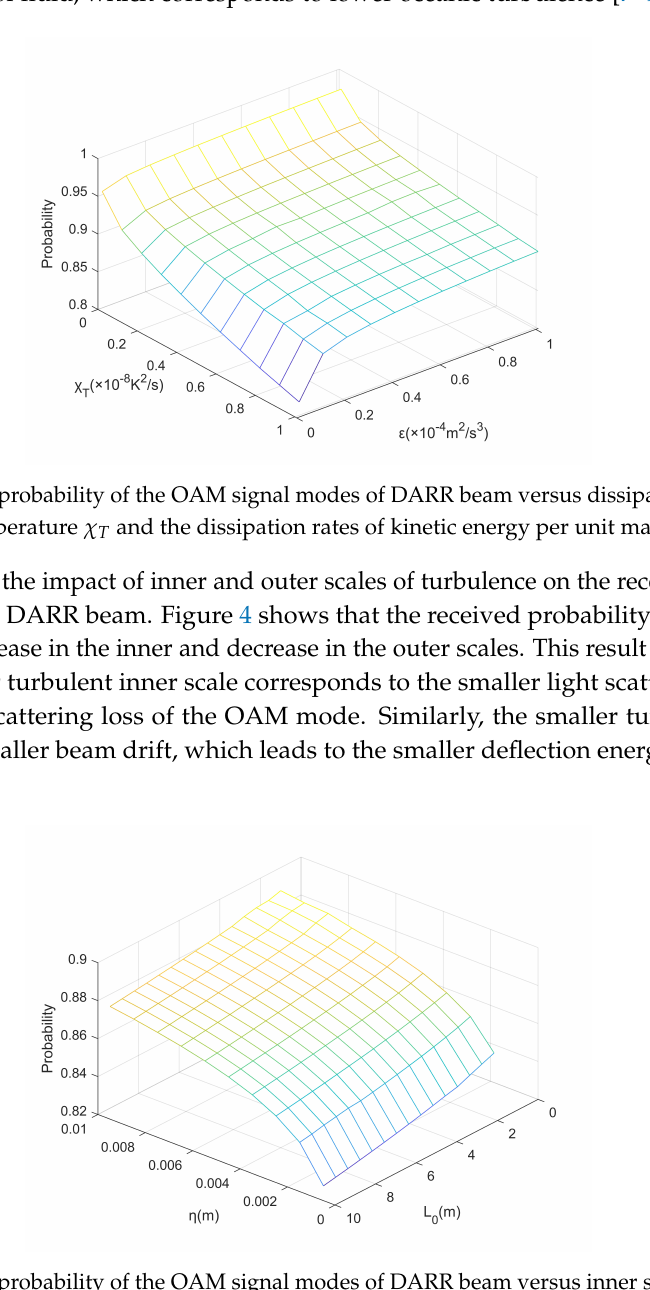
Figure 4. Received probability of the OAM signal modes of DARR beam versus inner scale η and outer scale L 0